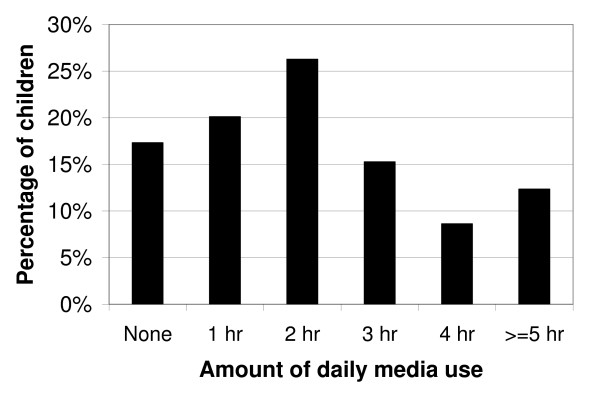
Percentage of US children, aged 2–5 years, by the amount of daily media use (n = 1792).